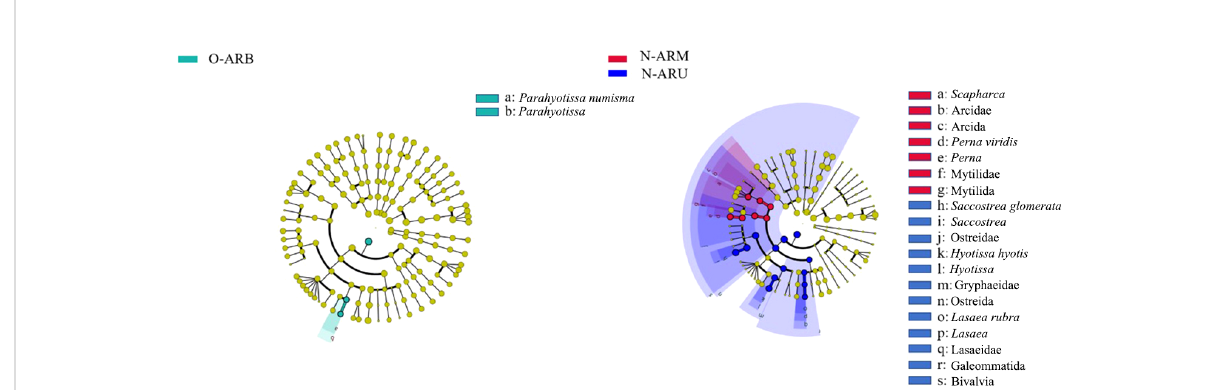
FIGURE 11 LEfSe results for the attached communities on the O-ARs and N-ARs. Nodes from inside to outside represent phylum, class, order, family, genus, and species. Biomarkers are represented by different colours, and yellow nodes represent taxa that do not play a signi fi cant role at each sampling location. The name of the taxa represented by the letters is shown in the legend on the